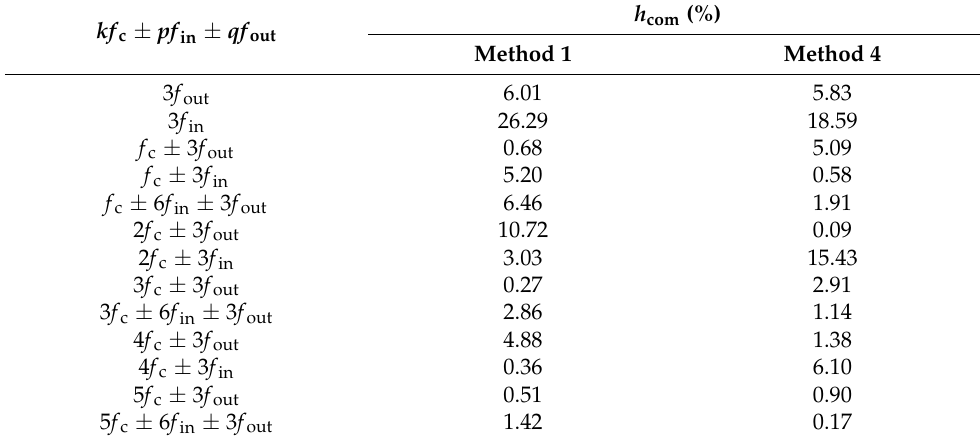
Table 7. Per-unit value of common-mode components of experimental waveform at m = 0.7. kf c ± pf in ± qf out